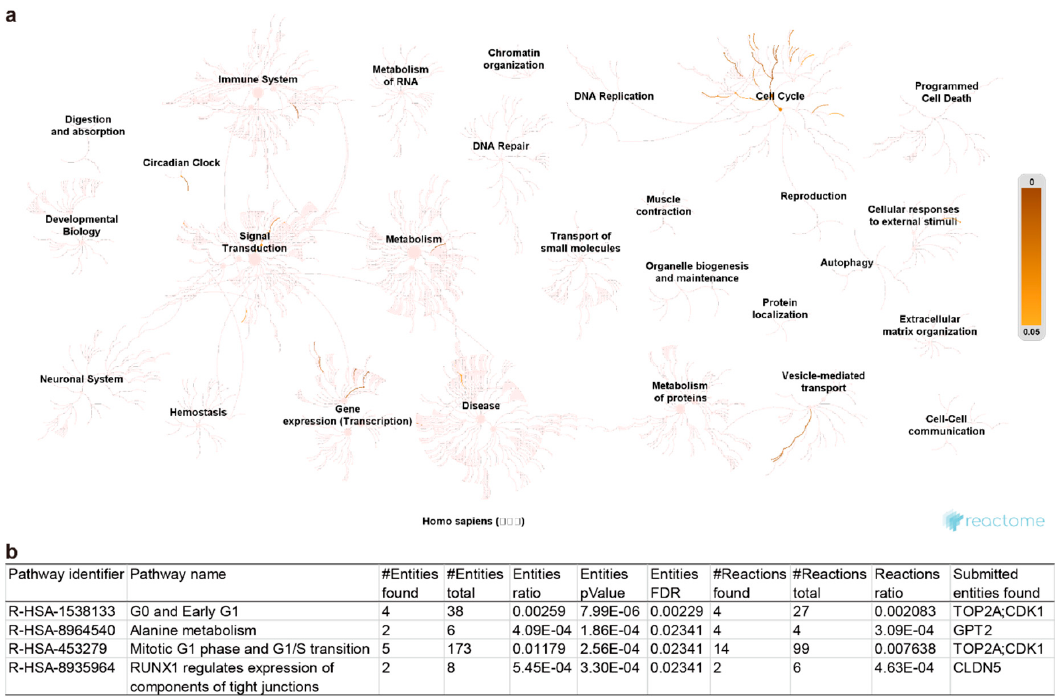
Figure 4. Pathway enrichment of the 35 common osteoarthritis (OA)-responsive differential expressed genes (DEGs) in cartilage and synovium has been conducted against the Reactome database. ( a ) The diagram of the distribution of the identified pathways. ( b ) The list of the identified pathways with a false discovery rate (FDR) less than 0.05. TOP2A — DNA topoisomerase 2-alpha ; CDK1 — cyclin-dependent kinase 1 ; GPT2 — Glutamate pyruvate transaminase 2/Alanine aminotransferase 2 ; CLDN5 — Claudin-5 .